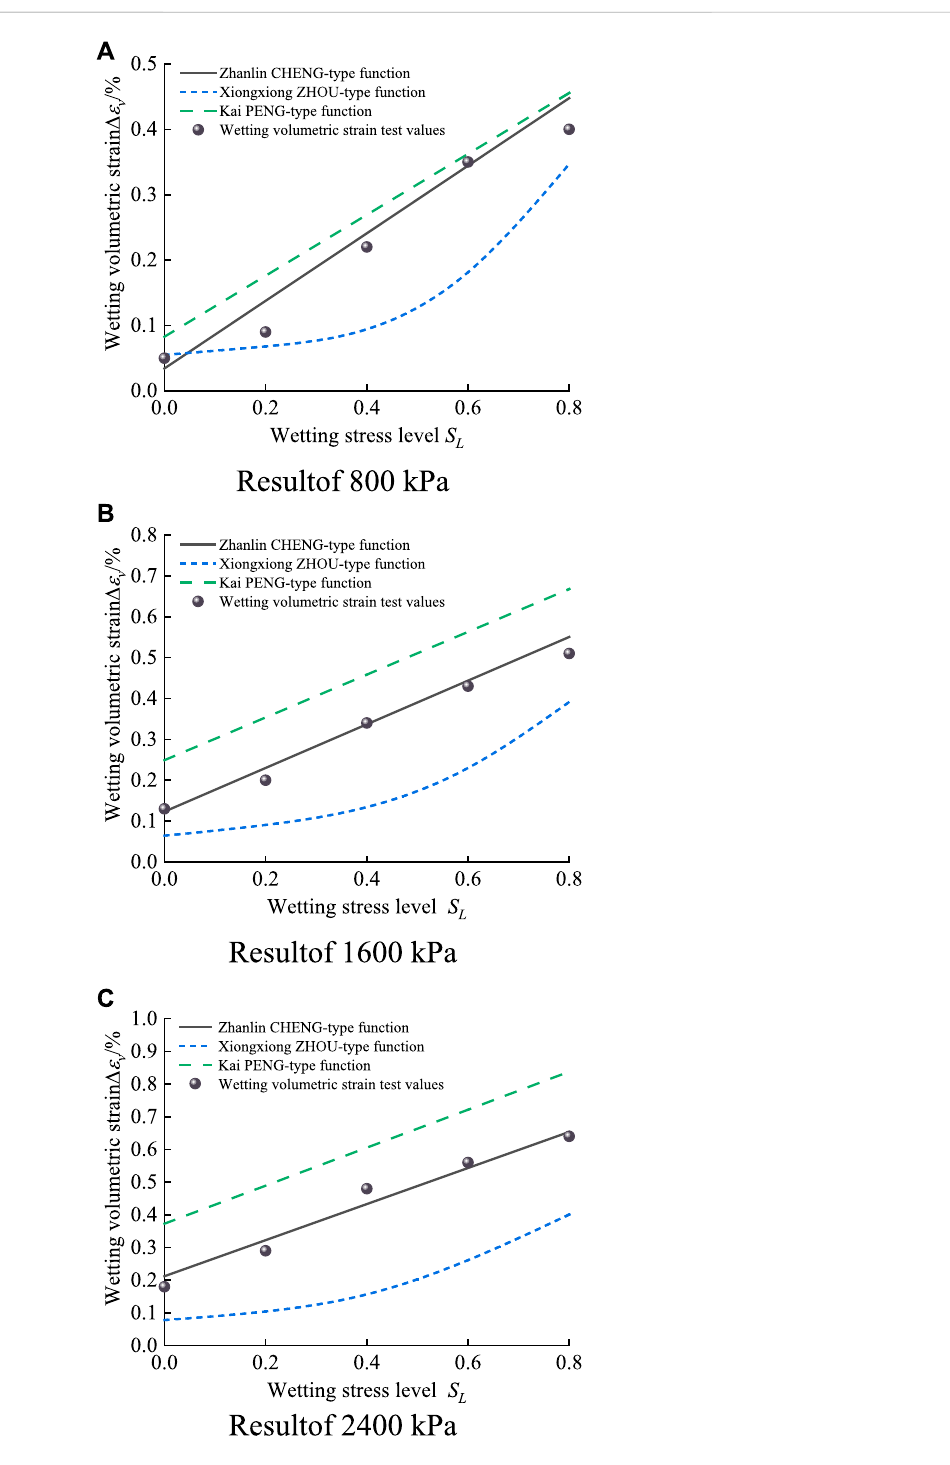
FIGURE 5 Comparisonofsimulationresultsandtestresultsofthreewettingvolumetricstrainmodels. (A) Resultof800 kPa (B) Resultof1,600 kPa (C) Resultof 2,400